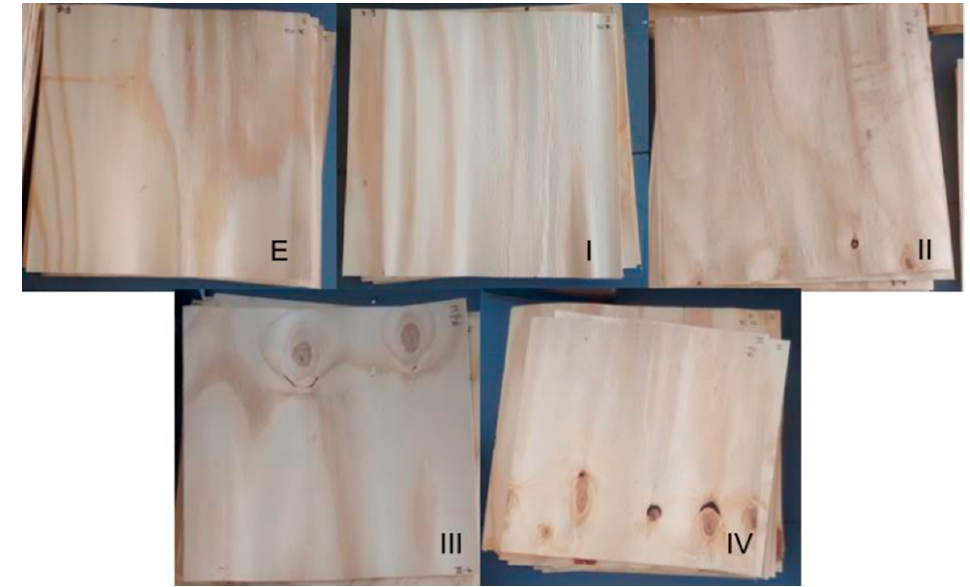
Figure 1. Veneer sorting by surface appearance using prescriptions from the ABNT ISO 2426-3: (E) no defects, (I) minimum defect, (II) isolated defects, (III), few defects, and (IV) several defects.